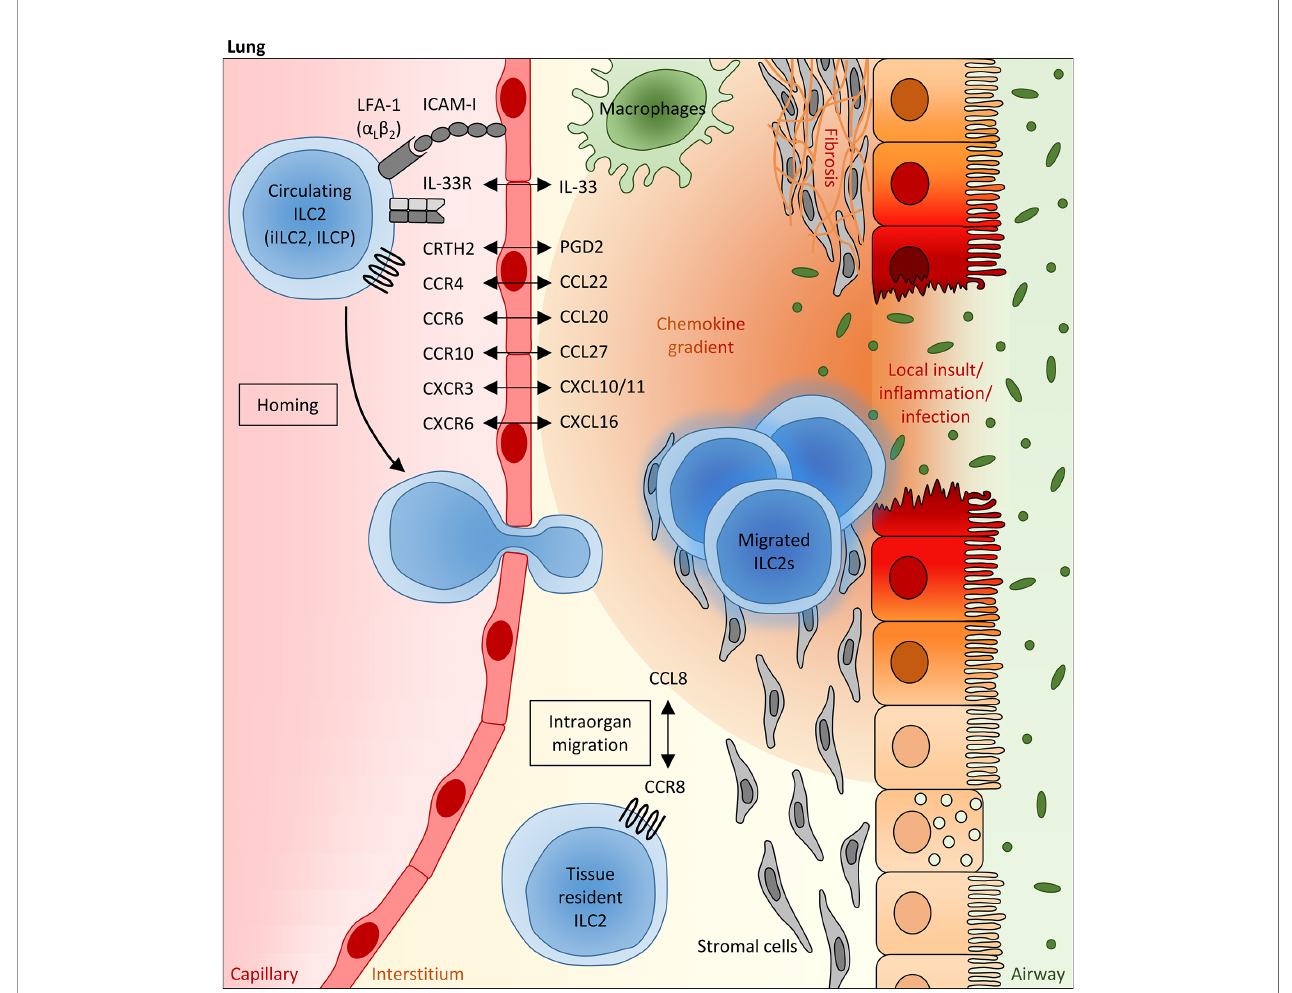
FIGURE 1 | Mechanisms regulating the pulmonary recruitment and spatial distribution of ILC2s during adulthood. Infectious or allergic lung in fl ammation and fi brosis are able to trigger the pulmonary recruitment of circulating blood ILC2s, including precursor ILCs (ILCP) egressed from the bone marrow, which is at least partly mediated via IL-33, as well as mature “ in fl ammatory ” ILC2s (iILC2s) primed in the gut. In this scenario, the local pulmonary milieu has been attributed to a crucial modulating function, which can in fl uence the migratory behavior of systemic ILC2s and their intraorgan distribution within the lung tissue. In particular, lipid mediators (PGD2), cytokines (e.g. IL-33) and chemokines (mainly CCL20, CCL22, CCL27, CXCL1, CXCL10 and CXCL16), whose local expression levels are markedly altered under in fl ammatory conditions and which can be largely attributed to epithelial and stromal cells as well as innate immune cells (representatively shown as macrophages), are assumed to function as potent numeric regulators of pulmonary ILC2 pools, allowing the adaption to local requirements. Besides the chemokine receptor pro fi le of ILC2s, the presence of speci fi c integrins (e.g. LFA-1) on their surface in fl uences the lung homing capacity of circulating ILC2s. Within the lung, the CCR8/CCL8 axis has been identi fi ed as a crucial regulator of the spatial distribution of pulmonary ILC2s, promoting their peribronchial enrichment in a niche de fi ned by stromal